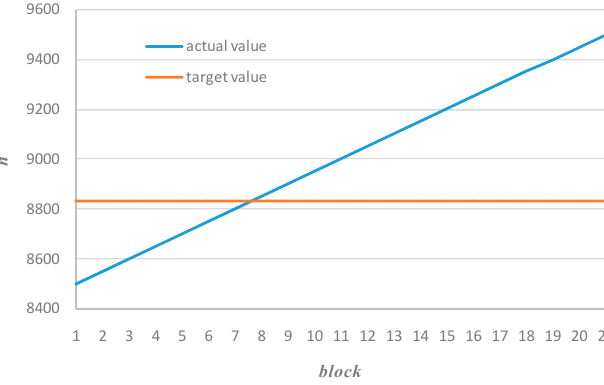
Figure 1. Ascending order of heating value and target value.